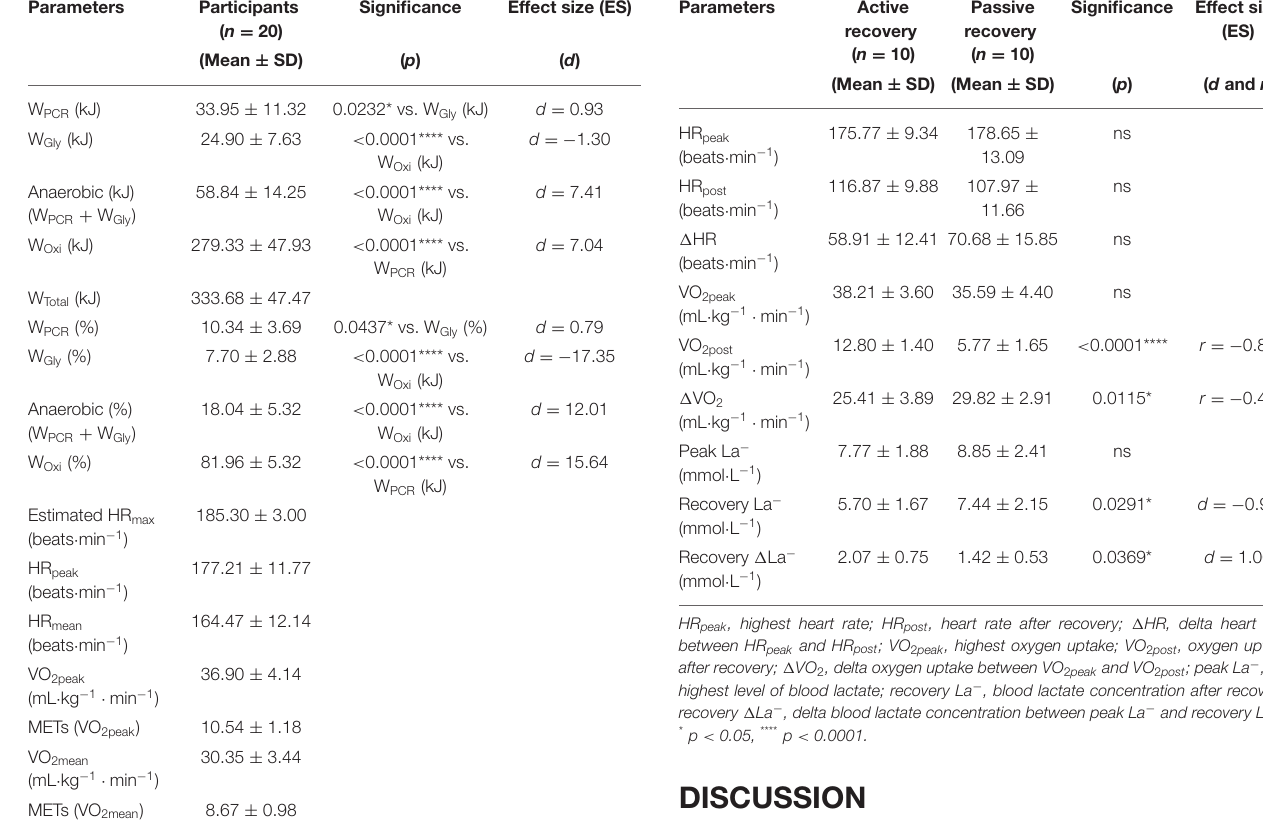
TABLE 3 | Physiological parameters during high-intensity hatha yoga and 10min recovery between different groups.